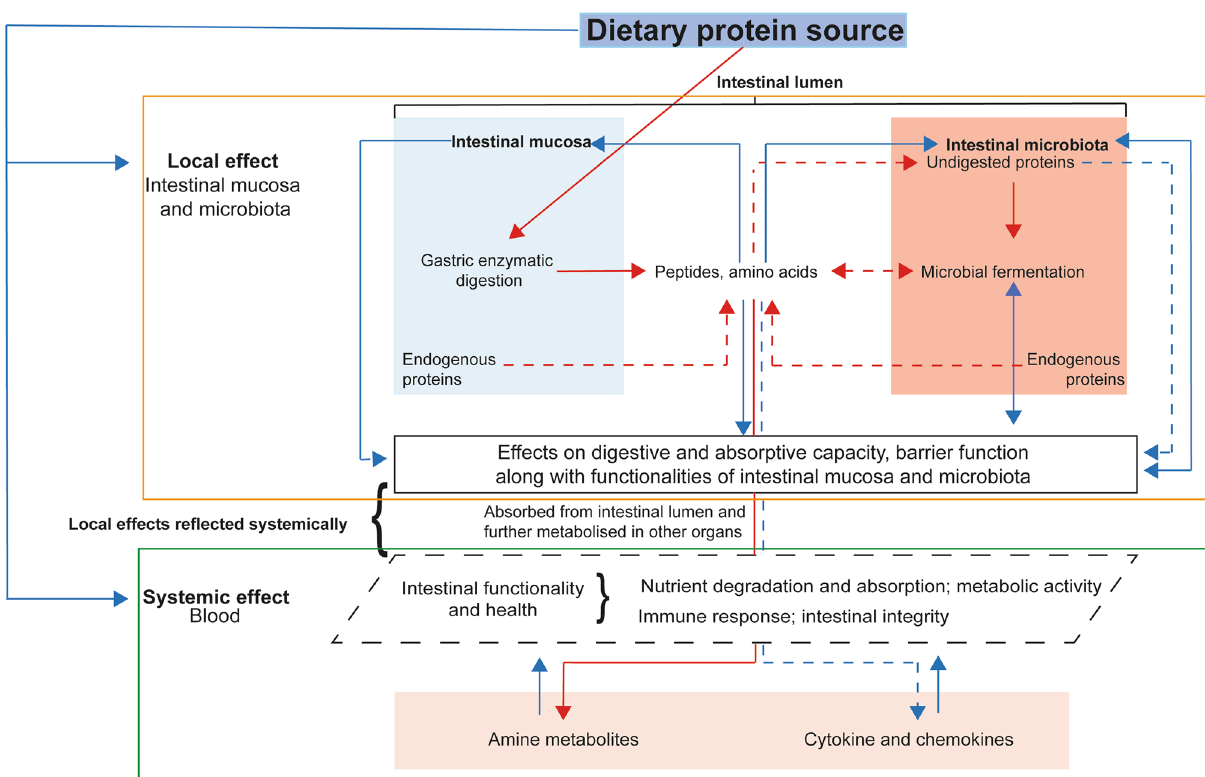
Figure 1. Schematic overview of effects of dietary protein sources on digestive physiology and systemic nutrient metabolism in pigs. Red arrows represent steps related to digestive physiology. Blue arrows relate to bio-functional effects of dietary protein sources and products released during their enzymatic hydrolysis. Continuous arrows represents major effects and dashed ones minor effects. The effects of dietary protein digestion at local (outlined in orange; black box, local effects) and systemic (outlined in green; dotted black box, local effects reflected systemically)